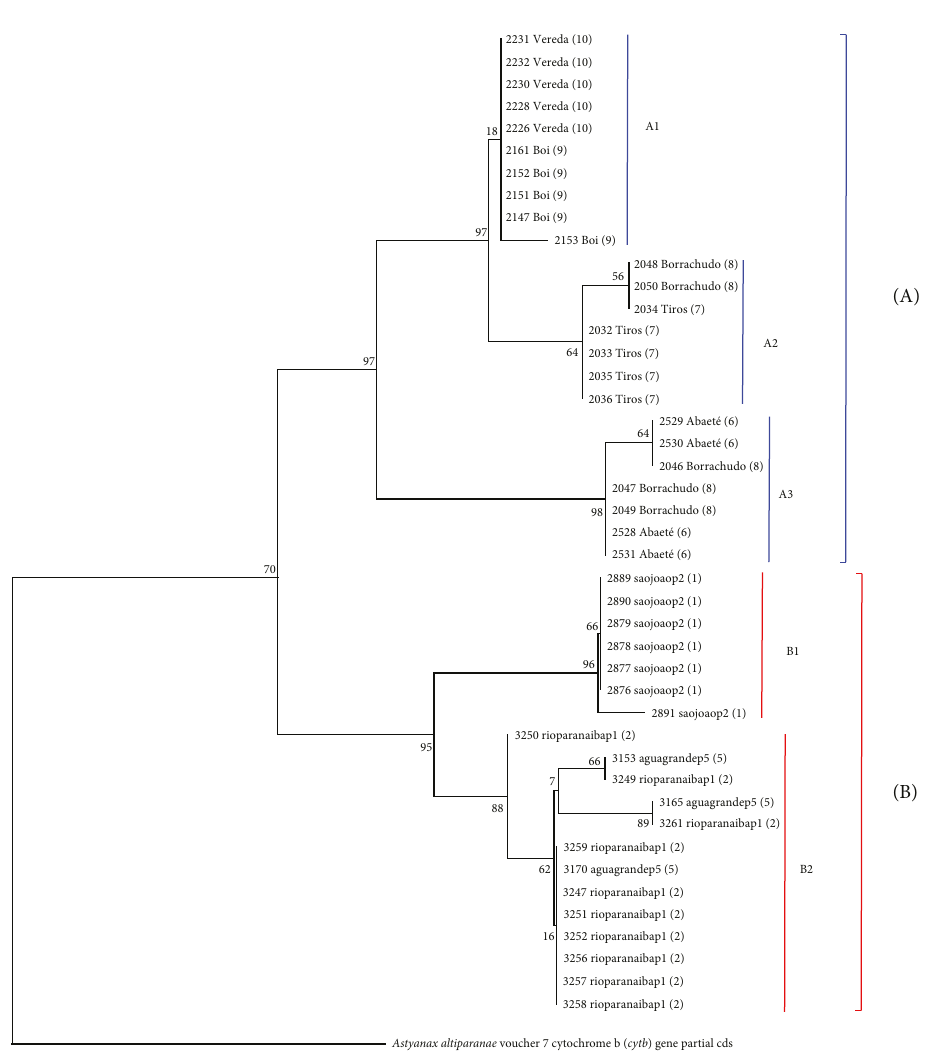
Figure5:MaximumlikelihoodphylogrambuiltbyMEGAv6.06.Thevaluesateachnodearethebootstrapfor1000replications.Thenumbers are equivalent to the sampling sites of Figure 1:1, S˜ao Jo˜ao river; 2, Parana´ıba River; 5, ´Agua Grande stream; 6, Abaet´e river; 7, Tiros